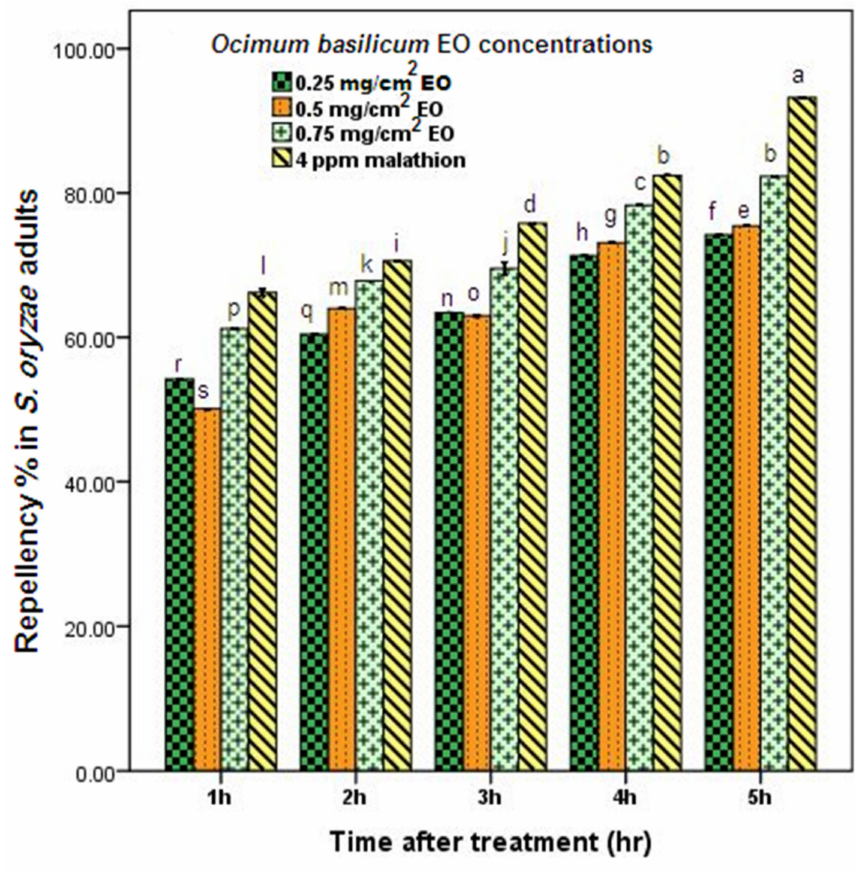
Figure 4. Impact of different concentrations (0.25, 0.5, and 0.75 mg/cm 2 ) from O. basilicum EOs on repellent % of S. oryzae adults at 1, 2, 3, 4, and 5 h exposure times (mean ± SD) compared with standard chemical pesticide (4 ppm malathion). Different letters indicate significant differences between different treatments at p < 0.05; LSD =